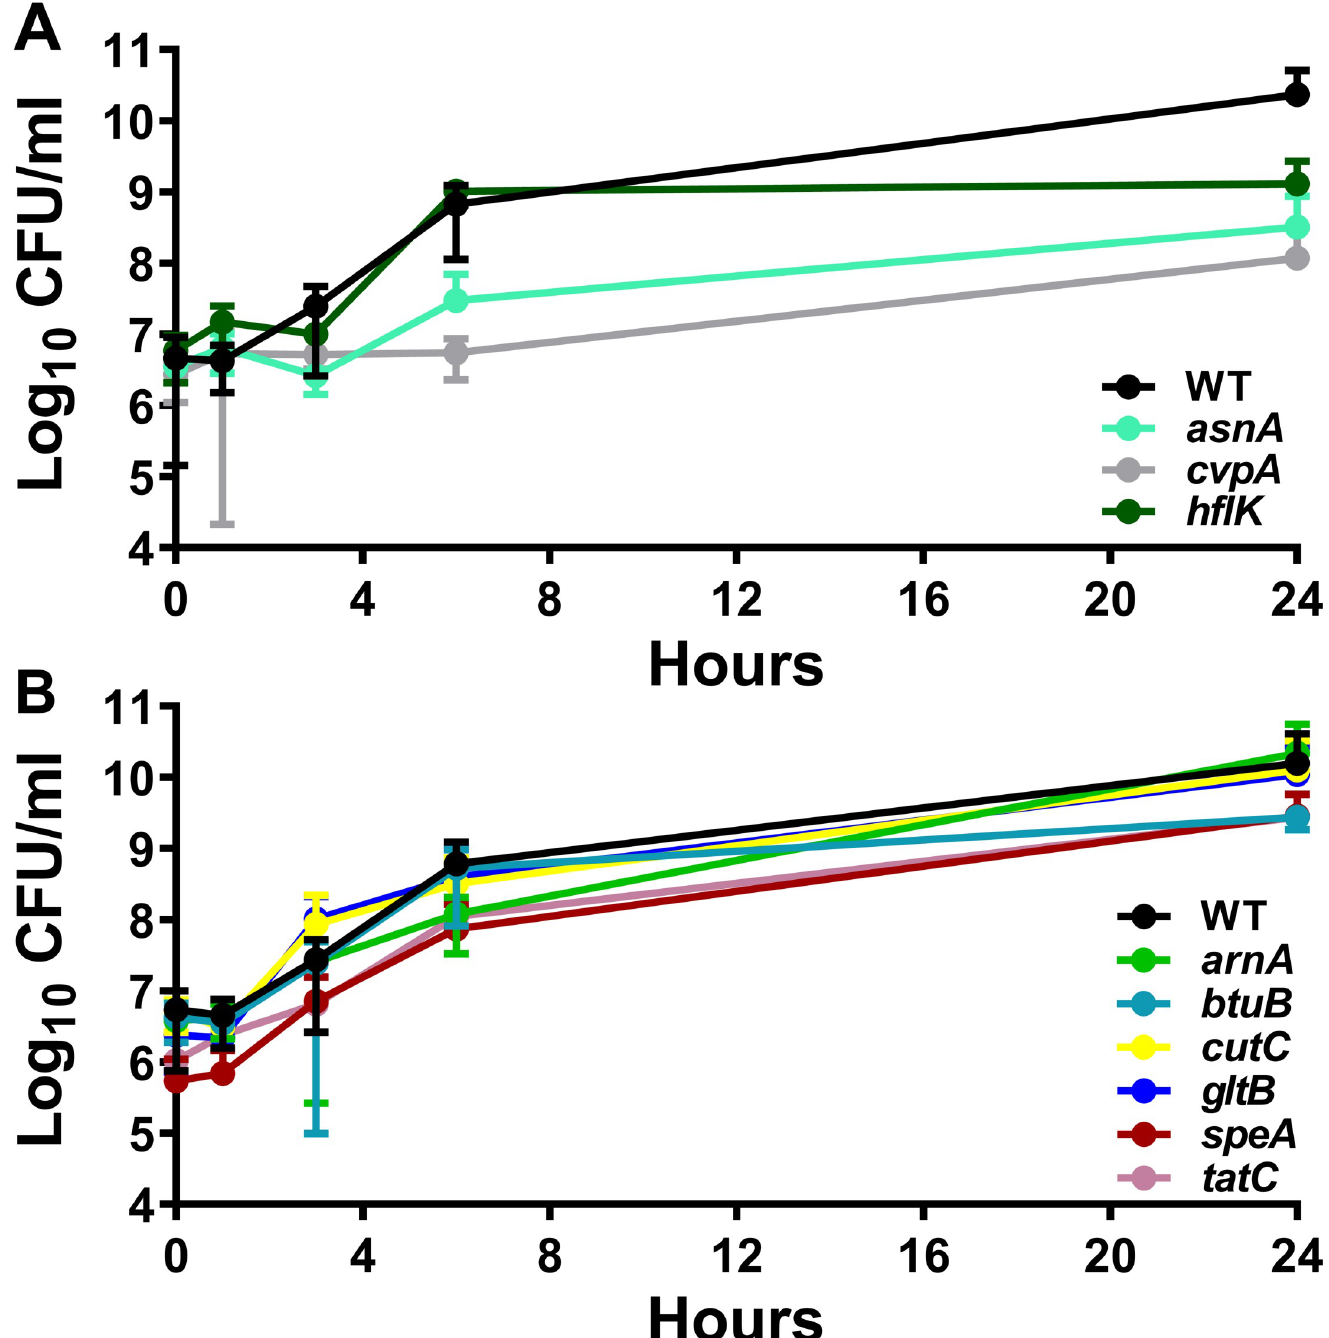
Fig 4. Serum growth characteristics of candidate fitness factor mutants. Growth of wild-type P. mirabilis and mutants over the course of 24 hours during static incubation at 37˚C with 5% CO2 in 50% naive mouse serum for genes that are (A) predicted to have a defect in serum ( asnA, cvpA, hflK ) or (B) candidate infection specific fitness factors ( arnA, btuB, cutC, gltB, speA, tatC ). Cultures were sampled at 0, 1, 3, 6, and 24 hours for enumeration of CFUs on LB agar. Error bars represent the mean ± standard deviation from three biological